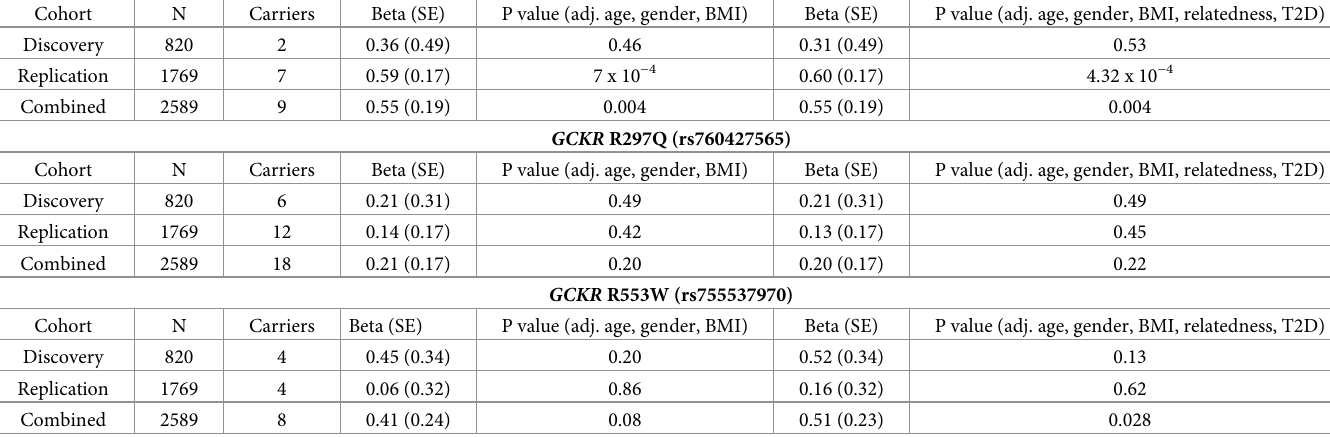
Table 3. Multivariate linear regression analysis showing association of three population-specific rare GCKR variants with serum triglycerides in discovery and repli- cation cohorts GCKR S105N